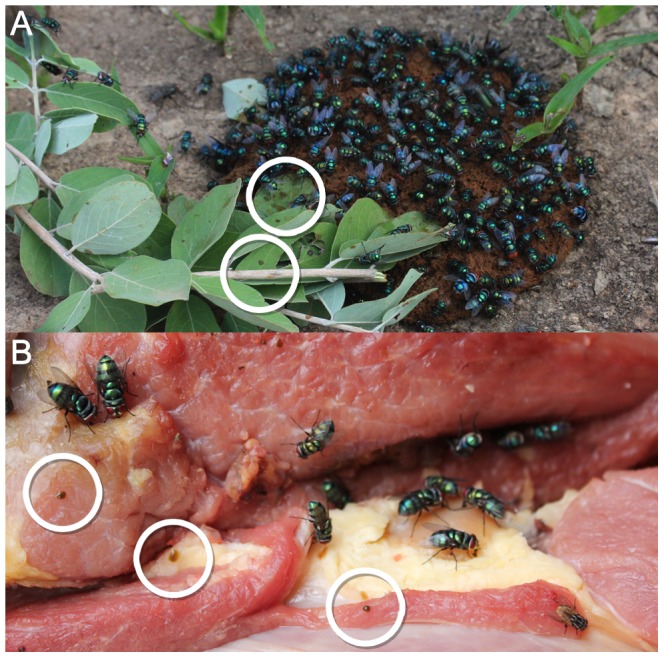

Chrysomya putoria dominating the surface of A human feces and B uncooked market stall meat.The rings demonstrate vomit drops and fly feces.